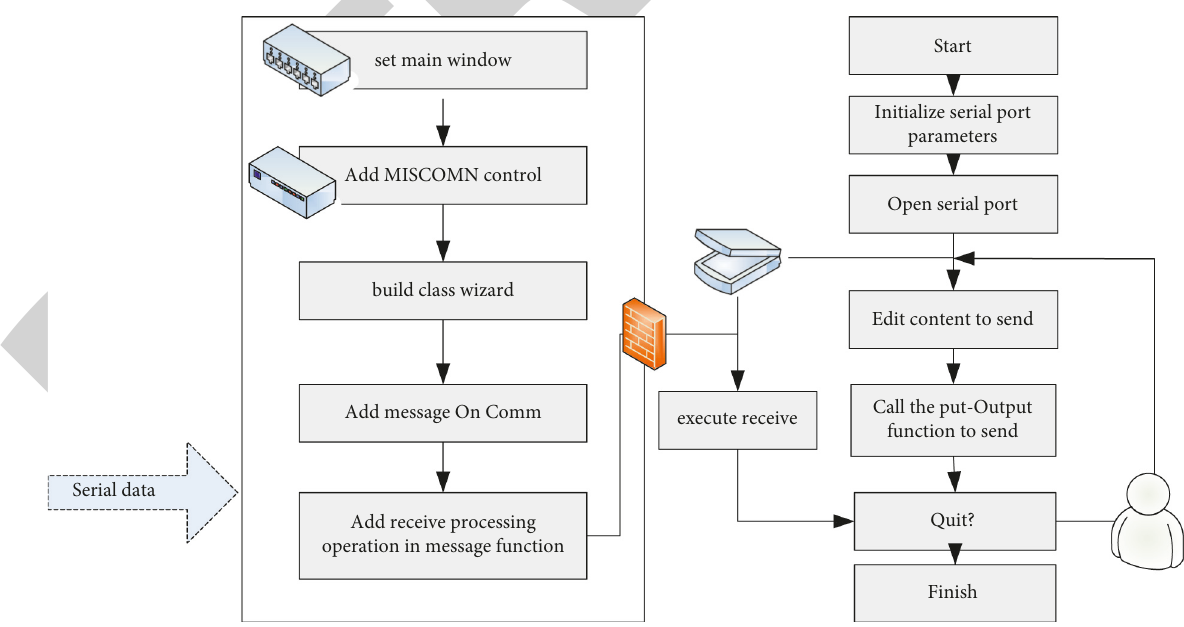
Figure 3: System composition